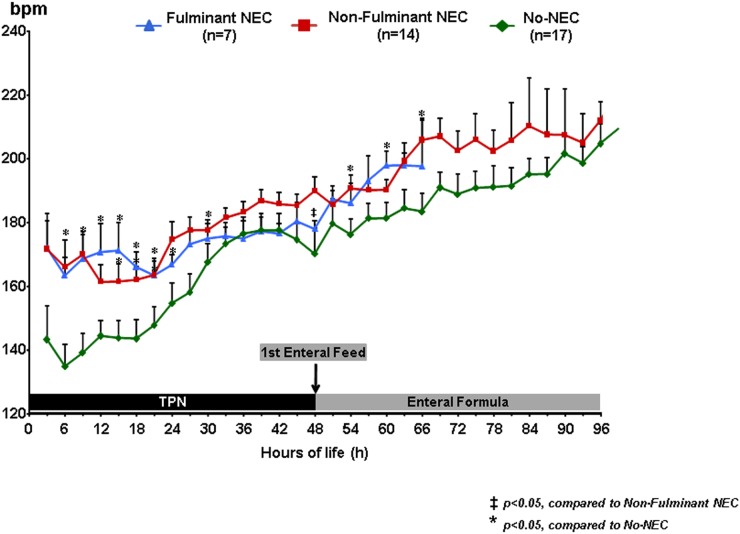
Continuous Heart Rate Measurements.Heart rate data stratified by NEC severity groups demonstrating an overall increasing trend in heart rates throughout the study period and that f-NEC and nf-NEC piglets were significantly more tachycardic during the first 24 hours of life than No-NEC piglets. ‡ = p<0.05, compared to Non-Fulminant NEC; * = p<0.05, compared to No-NEC.